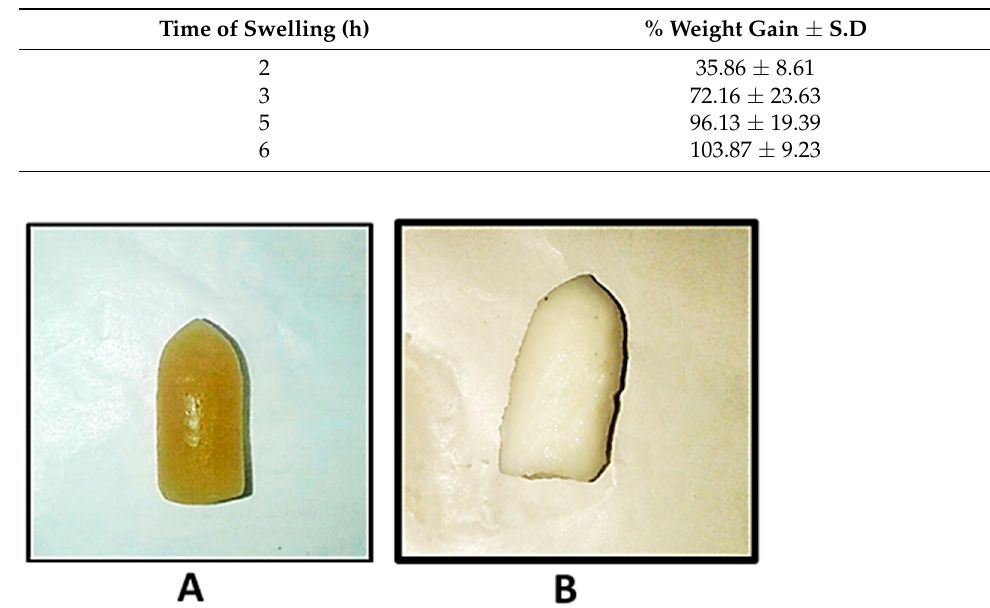
Figure 1. Suppositories after ( A ) 0 h and ( B ) 6 h of swelling ( n =3). SVF: simulated vaginal fluid.